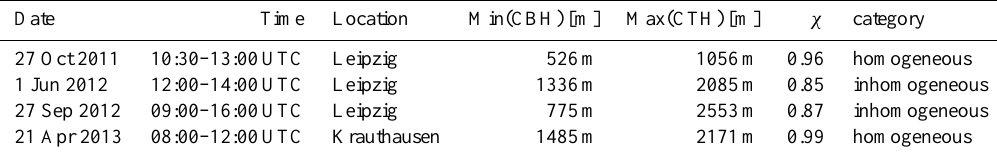
Table 2. Cases used within this study sorted by date. The minimum cloud base height (CBH) and the maximum cloud top height (CTH) of the liquid cloud layer investigated are presented together with the temporally averaged inhomogeneity parameter ( χ ) as in Cahalan et al. (1994) calculated from τ of the ± 2 surrounding SEVIRI pixels for each observation time. Furthermore the category for each case is